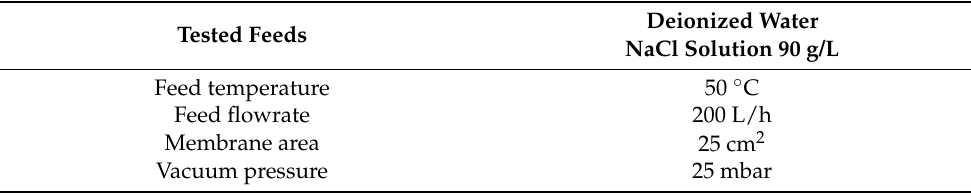
Table 2. VMD tests conditions.